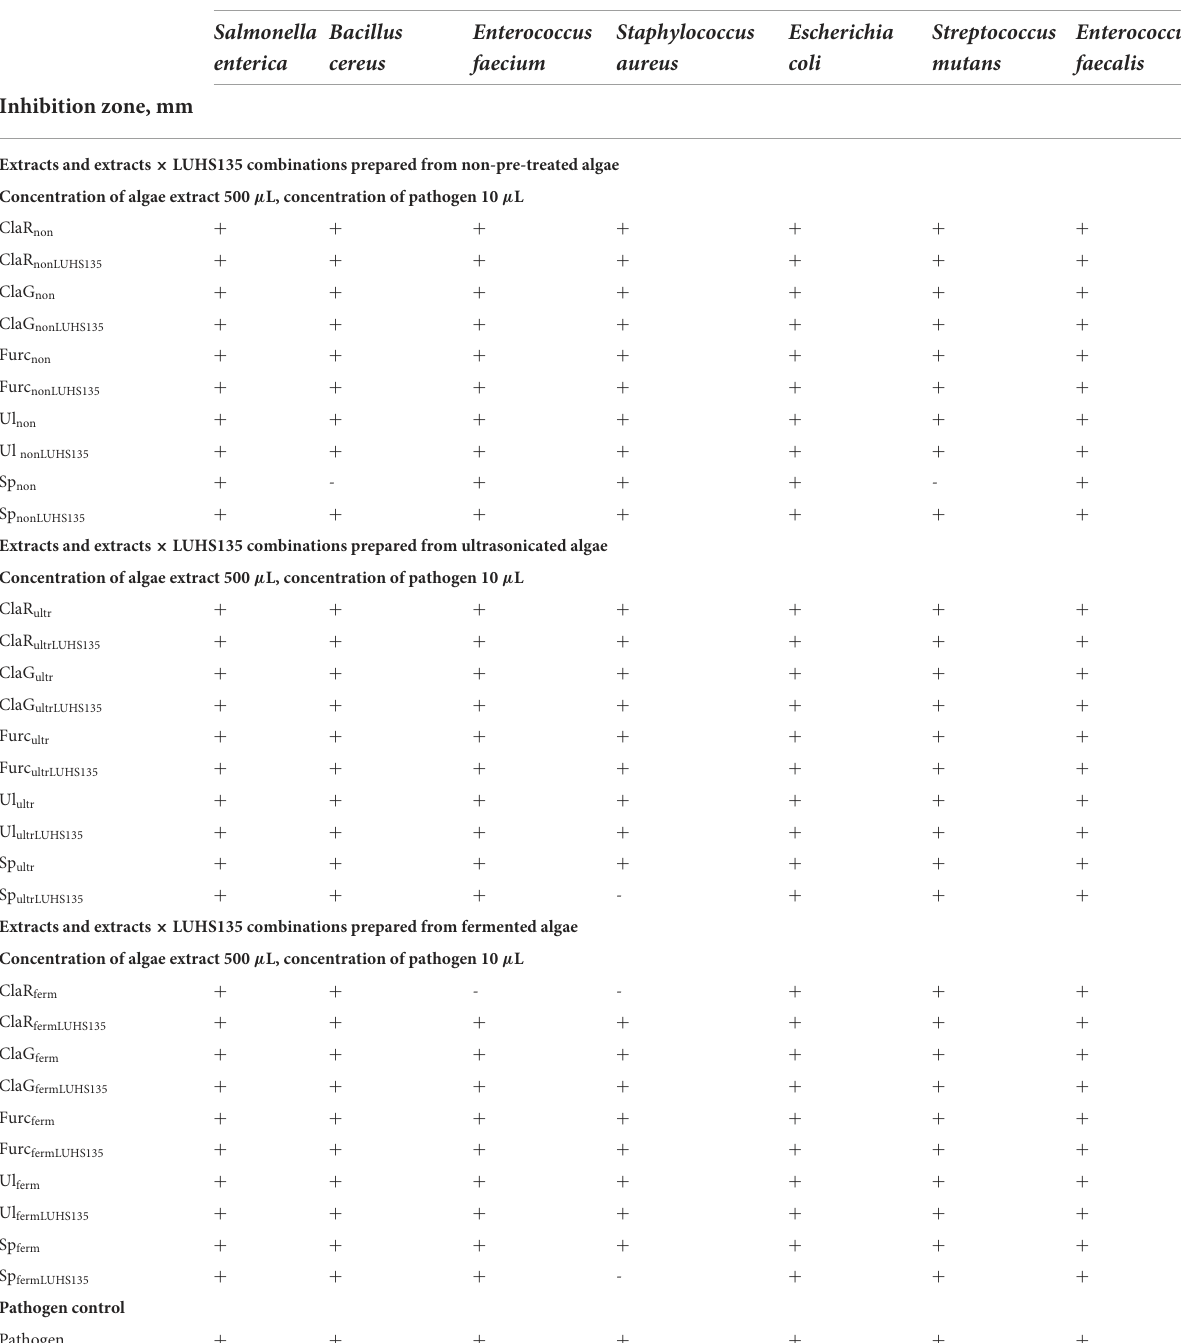
TABLE 5 Antimicrobial activity of the algae extracts and algae extracts × LUHS135 combinations evaluated in liquid medium by testing concentration of algae extract and/or algae extract × LUHS135 combination at a concentration of 500 µ L and pathogen concentration at 10 µ L. Extracts and extract × LUHS135 combination